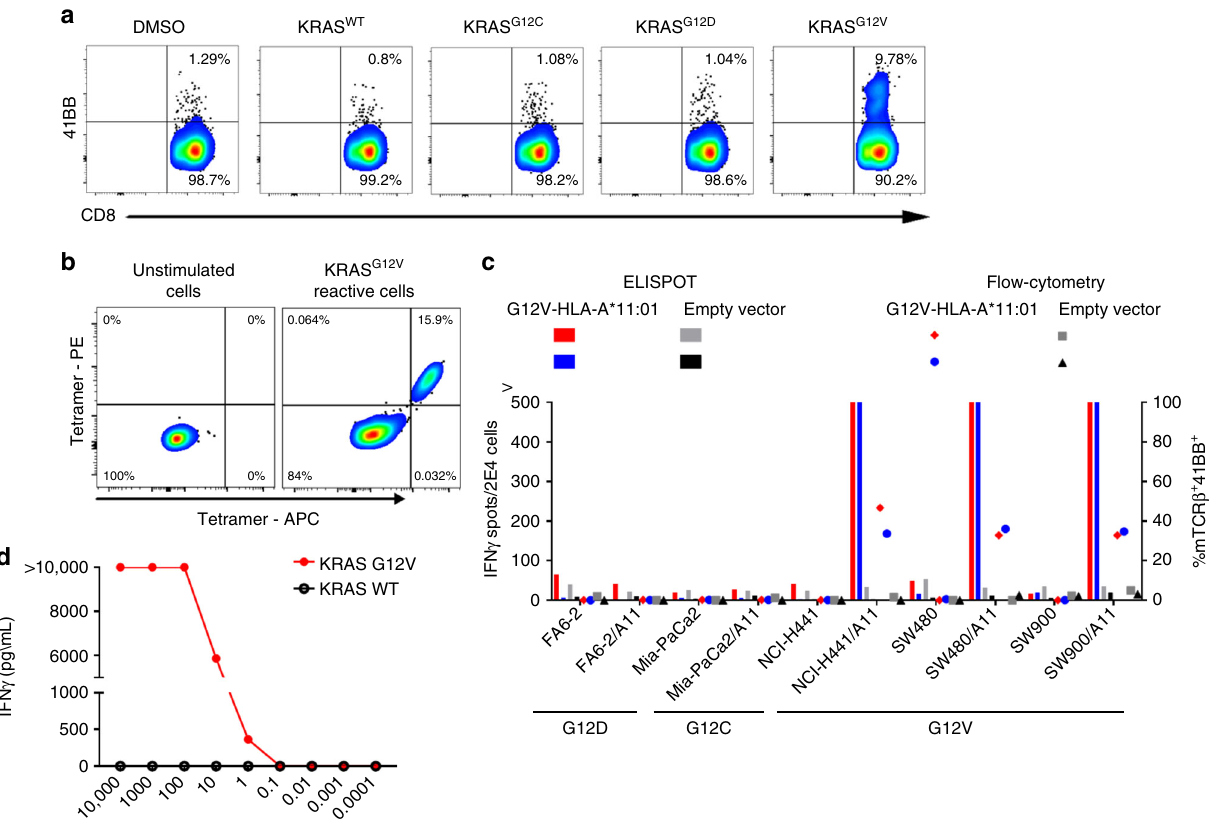
Fig. 3 Identi fi cation, isolation, and analysis of KRAS G12V -reactive TCR. a 41BB-enriched CD8 memory T cells were expanded, and their reactivity was tested against autologous DCs pulsed with the indicated peptides. b 41BB-enriched CD8 memory T cells are stained with KRAS G12V 9mer tetramers; unstimulated CD8 cells were used as control (left). c 41BB upregulation and ELISPOT IFN γ secretion assay of TCR-transduced allogeneic T cells. T cells co-cultured with cell lines naturally expressing G12 mutations ± HLA-A11 transduction. d IFN γ secretion of TCR-transduced cells against autologous DCs pulsed with the indicated concentrations of mutated and WT 9mers. A representative of at least three